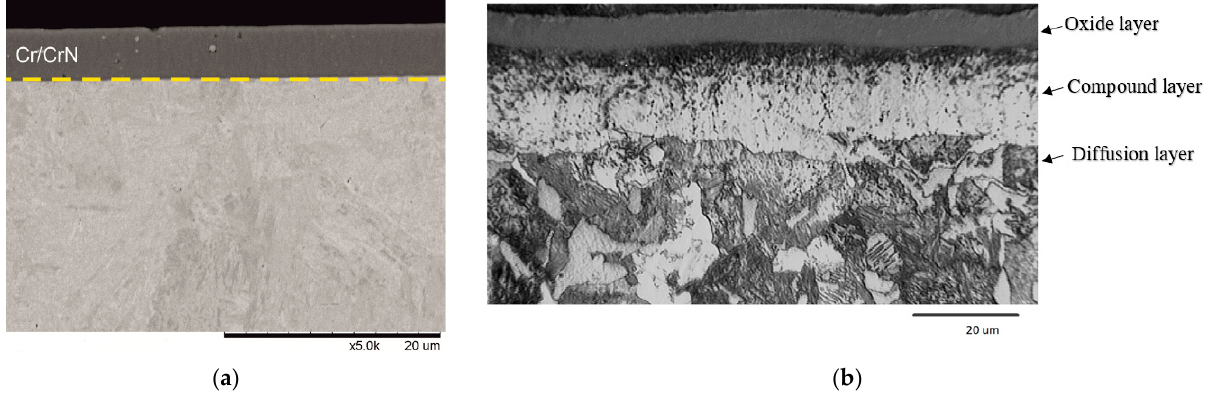
Figure 3. The microstructure of the tested coatings produced on AISI 1045 steel ( a ) Cr/CrN PVD, ( b ) gas nitrided with subsequent oxidation and impregnation.